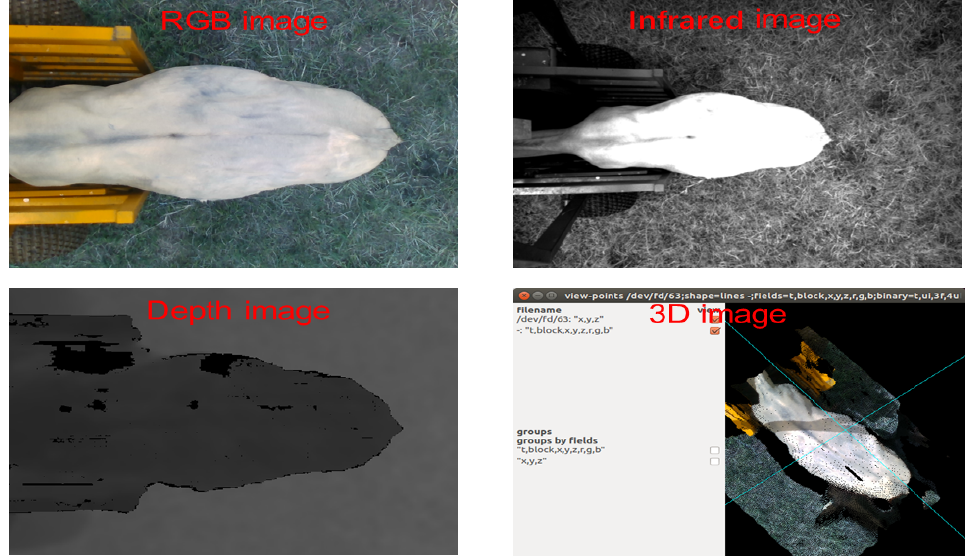
Figure 2. Examples of acquired images from an Intel RealSense D435